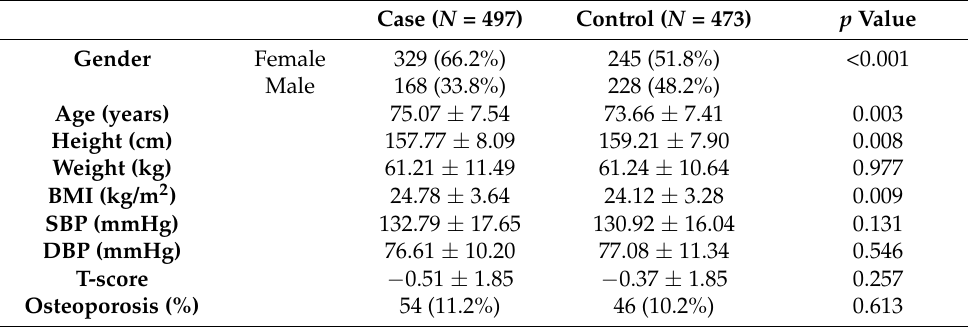
Table 1. Characteristics of subjects with knee osteoarthritis and control subjects. Case ( N = 497) Control ( N = 473) p Value Gender Female 329 (66.2%) 245 (51.8%)